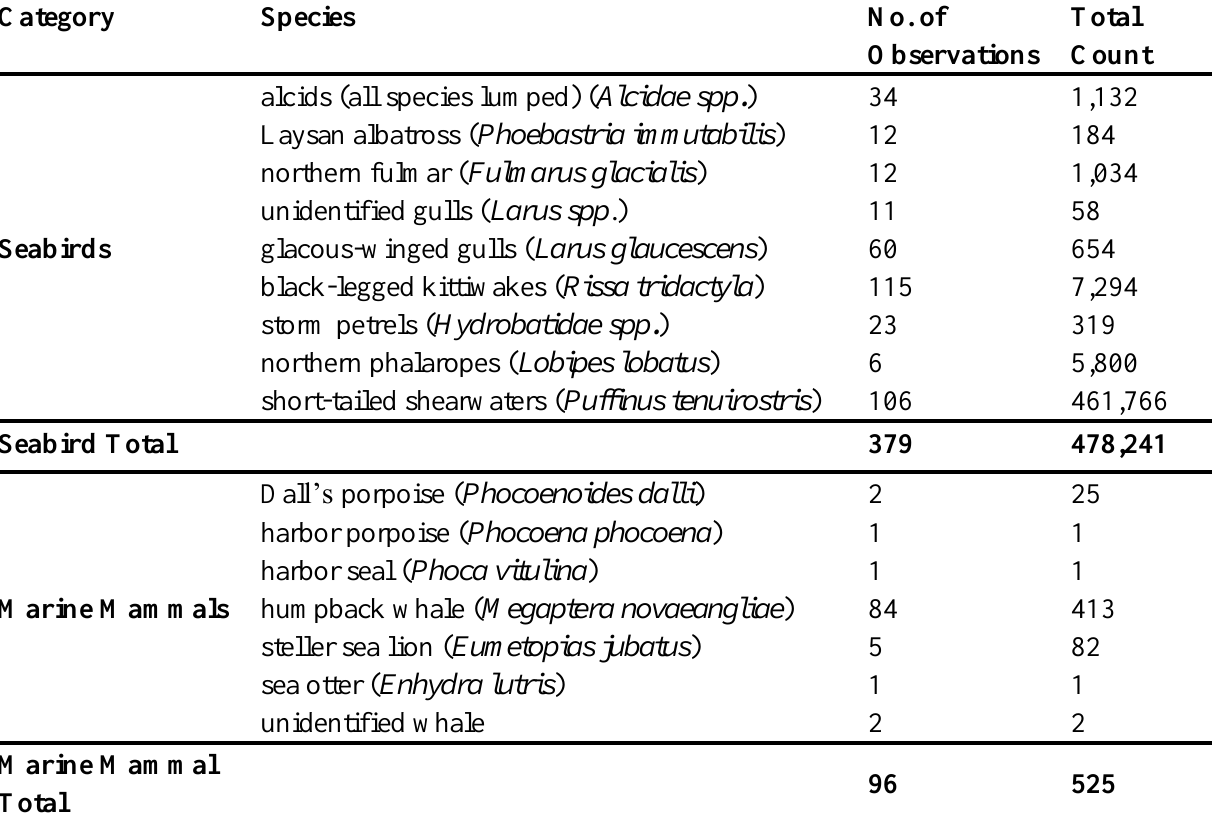
Table S2. Number of observations of groups of animals and total counts of individuals by species of sea birds and marine mammals from visual aerial surveys.